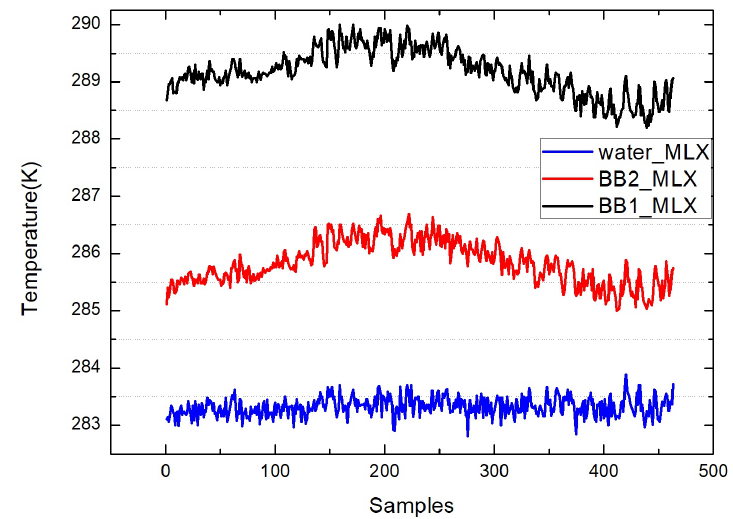
Figure 8. The infrared thermometer directly measures the output values of the high-temperature